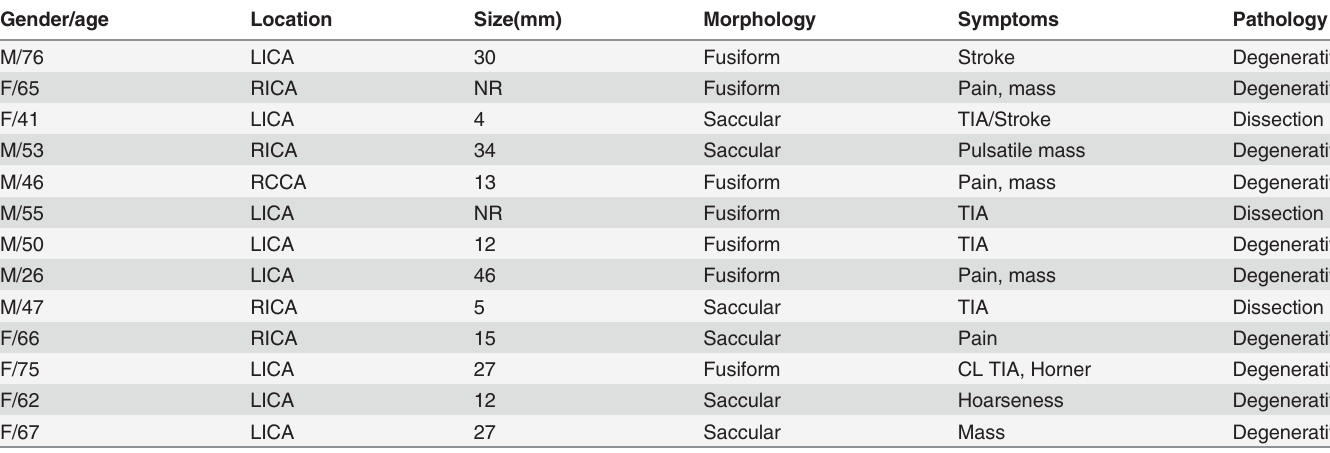
Table 2. Aneurysm characteristics.